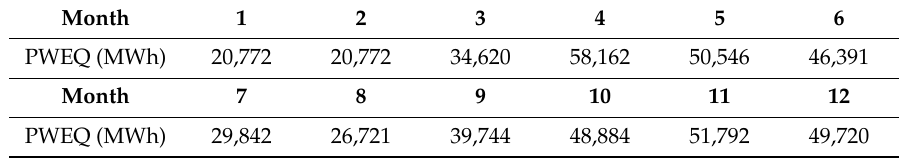
Table 8. The monthly predicted wind-power electrical energy.